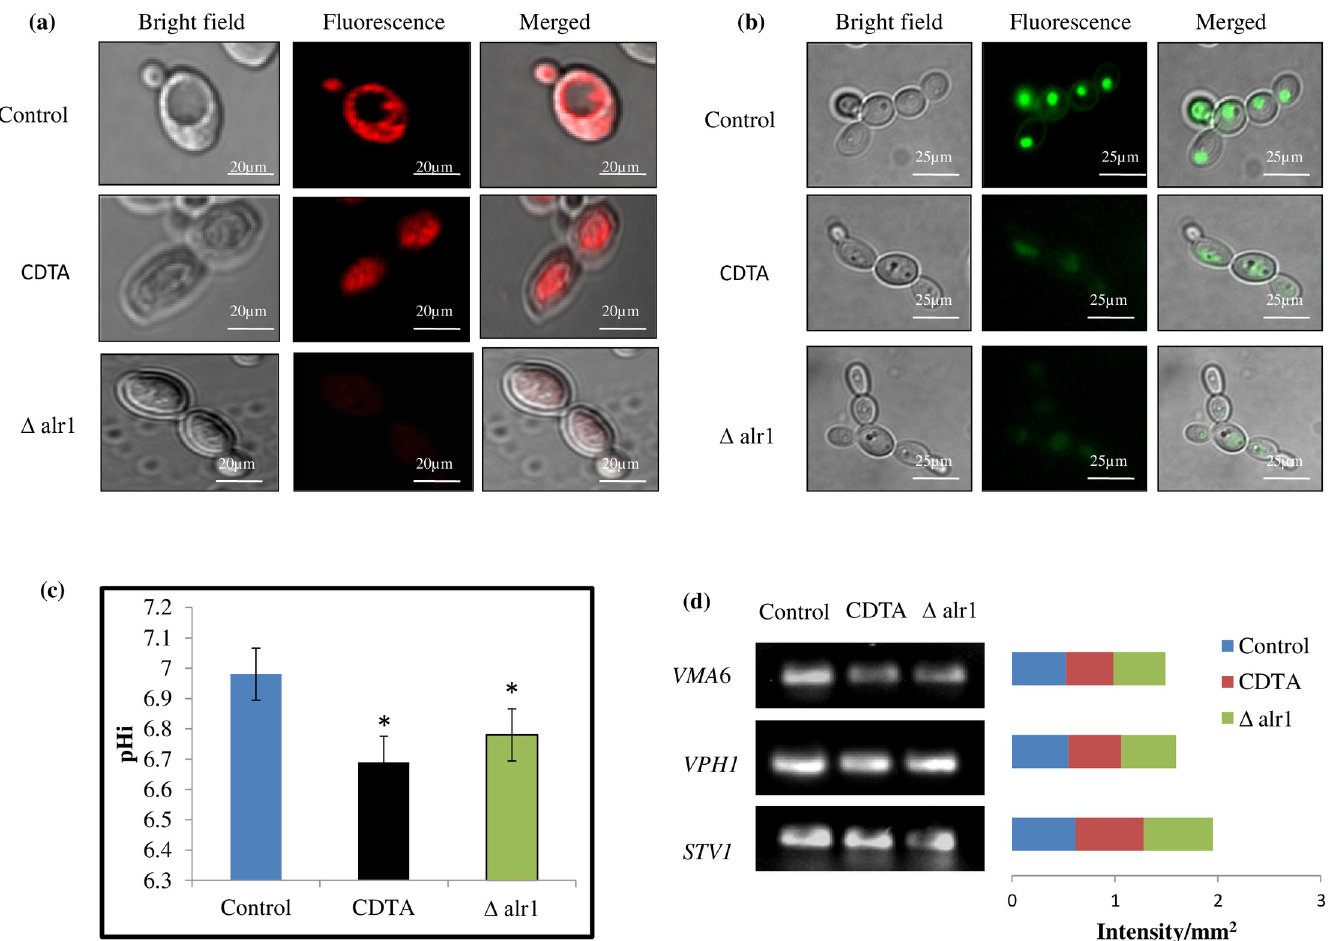
Fig 8. Vacuolar homeostasis under Mg deprivation. ( a ) Vacuolar morphology of control, CDTA treated and Δ alr1 C . albicans observed using FM4-64 staining. Scale bar = 20 μ m. ( b ) Vacuolar pH of control, CDTA treated and Δ alr1 C . albicans observed using quinacrine staining. Scale bar = 25 μ m. (c) Cytosolic pHi under Mg deprivation. Measurement of Intracellular pH (pHi) in control, CDTA treated and Δ alr1 C . albicans . The bar graph depicts mean of pHi and pHi ± SD of three independent sets of experiments, � depicts p value < 0.05. (d) RT-PCR under Mg deprivation. Left panel represents gel images of differentially expressed genes ( VMA6 , VPH1 and STV1 ) in C . albicans . Right panel depicts the quantitation (density expressed as Intensity/mm 2 ) of the respective transcripts. Image J software was used to measure the intensity of each band.